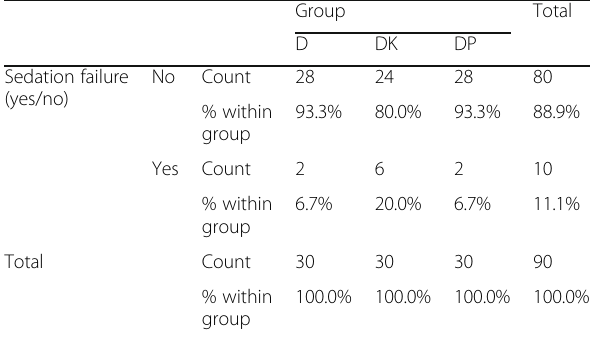
Table 7 Sedation failure (yes/no)